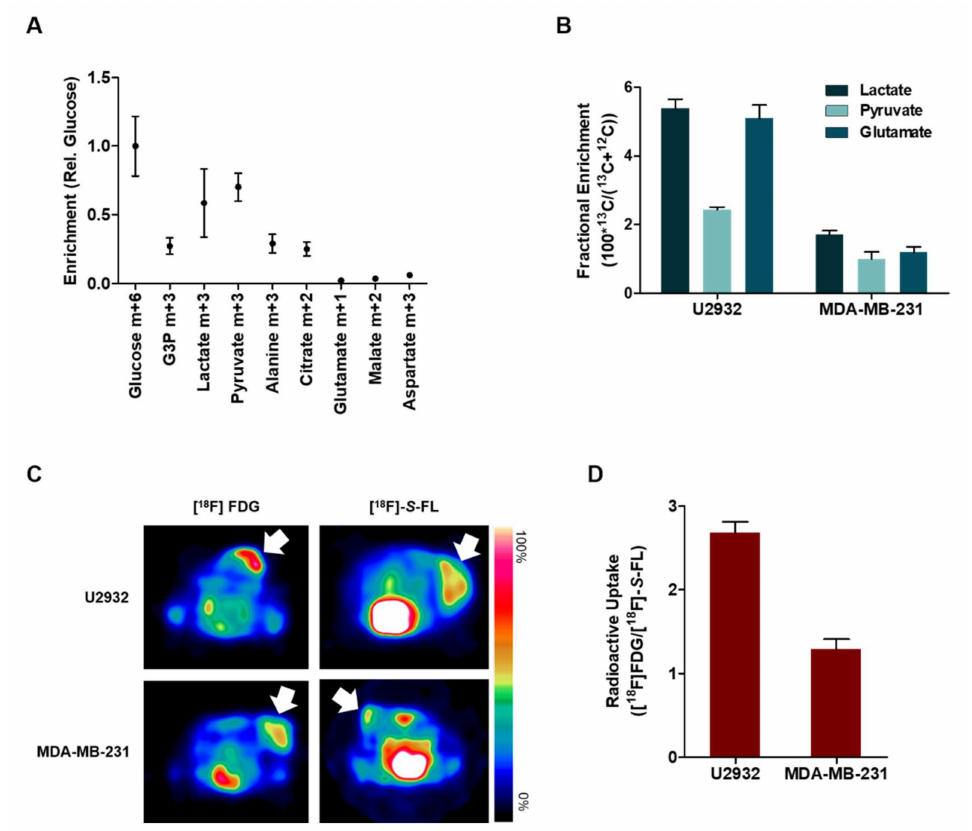
Figure 3. DLBCL tumor models utilize lactate as metabolic fuel. ( A ) Tissue enrichment of glucose m + 6, glyceraldehyde-3-phosphate (G3P) m + 3, lactate m + 3, pyruvate m + 3, alanine m + 3, citrate m + 2, glutamate m + 1, malate m + 2 and aspartate m + 3 in U2932 tumor-bearing mice infused with D-[ 13 C 6 ]Glucose normalized to glucose enrichment. ( B ) Fractional enrichment of lactate, pyruvate and glutamate in U2932 and MDA-MB-231-tumor bearing mice infused with L-[1- 13 C]lactate. ( C ) Representative axial PET images of U2932 and MDA-MB-231 xenografts ( C ) and comparative radioactive uptake of [ 18 F]- S -FL (30 min) and [ 18 F]FDG (1 h) in both tumor models ( D ), expressed as the ratio of [ 18 F]FDG relative to mean [ 18 F]- S -FL. All data are average ± SEM ( n =